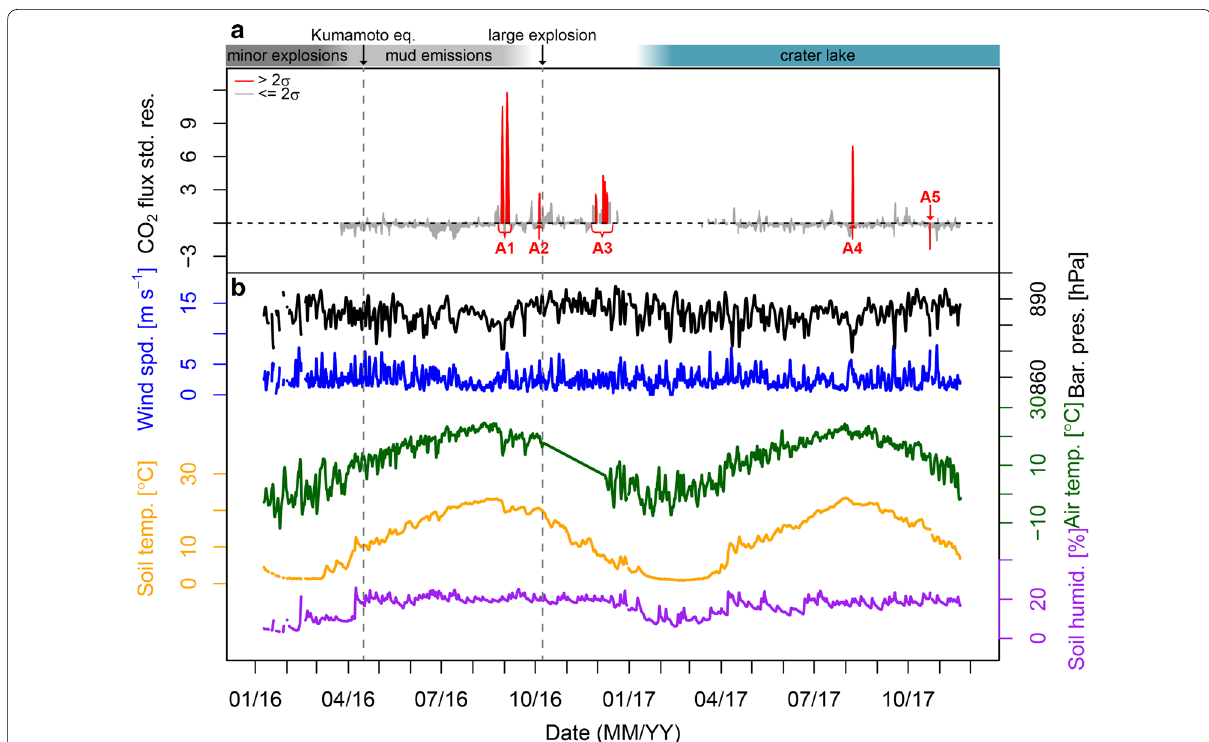
Fig. 9 a Time series of the standardized daily average for the residuals of soil CO 2 flux. Only values > 2 σ are colored with red. A1–A5 denote the CO 2 flux anomalies discussed in the text. The main volcanic and seismic events are shown in the top of the figure. b Time series of the daily average of the environmental parameters that were included in the model. From the top, barometric pressure (black), wind speed (blue), air temperature (green), soil temperature (orange), and soil humidity (purple) are